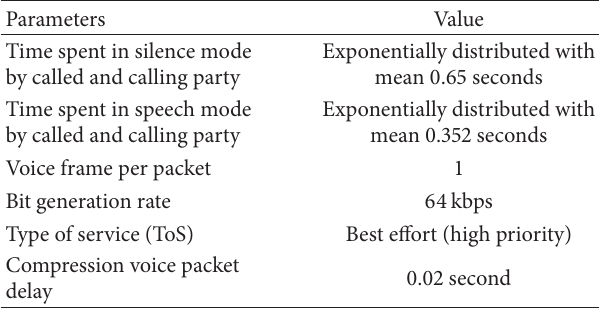
Table 7: The traffic model for voice application.